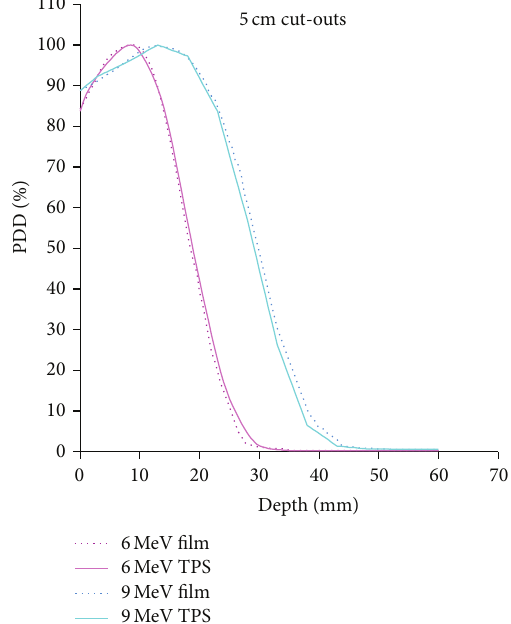
Figure 3: Percent depth dose curve comparisons between measured data using Semiflex ion chamber and EBT films using 5 cm circular cone at 100cm SSD. All curves are normalized to 100%. As measure- ments made by Semiflex ion chamber are represented by solid lines, EBT film measurements are represented by dotted